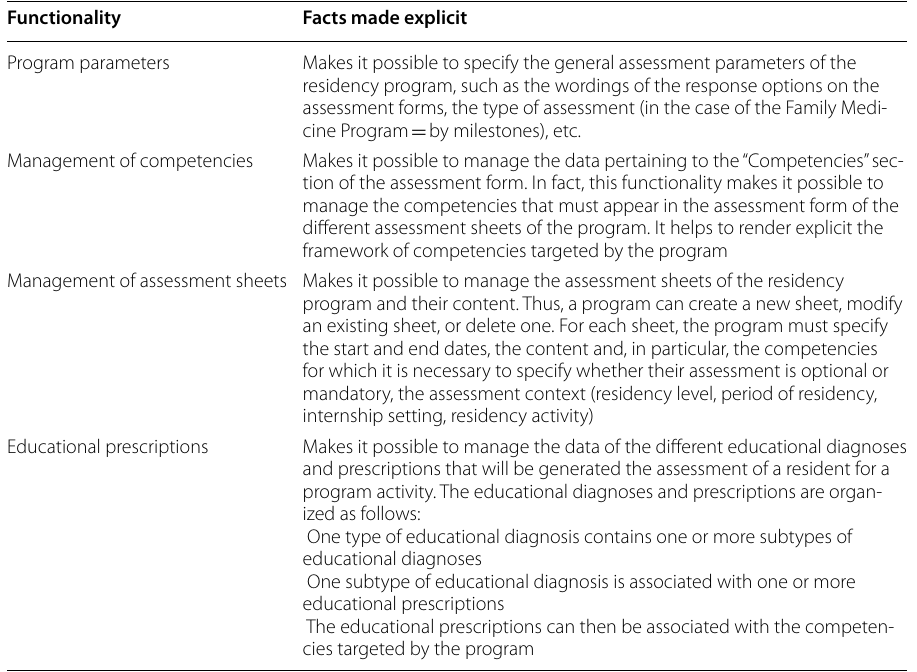
Table 1 Management tool functionalities and facts made explicit Functionality Facts made explicit Program